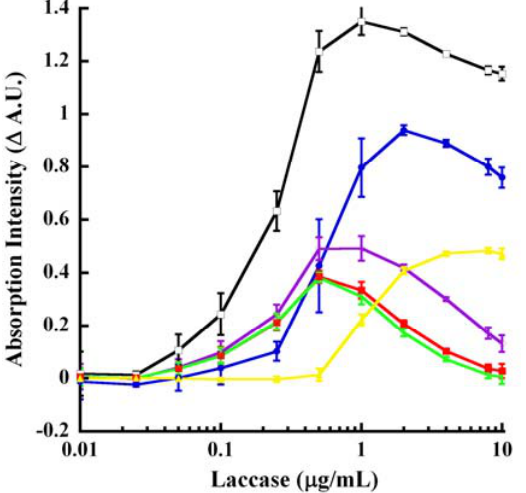
Figure 6B. Endpoint laccase dose-response of CA oxidation. Laccase reactions (from Figure 6A) were terminated at 60 minutes with 250mM KOH. The tracings represent the absorption wavelengths of 250 nm (blue), 290 nm (red), 310 nm (purple) and 320 nm (aqua). All tracings represent the difference between the absorption intensities of the reactions without enzyme subtracted from the absorption intensities of reactions in the presence of laccase (B − S), except for 250 nm which is the discrimination between the signal (with laccase) and the background (without laccase) (S −